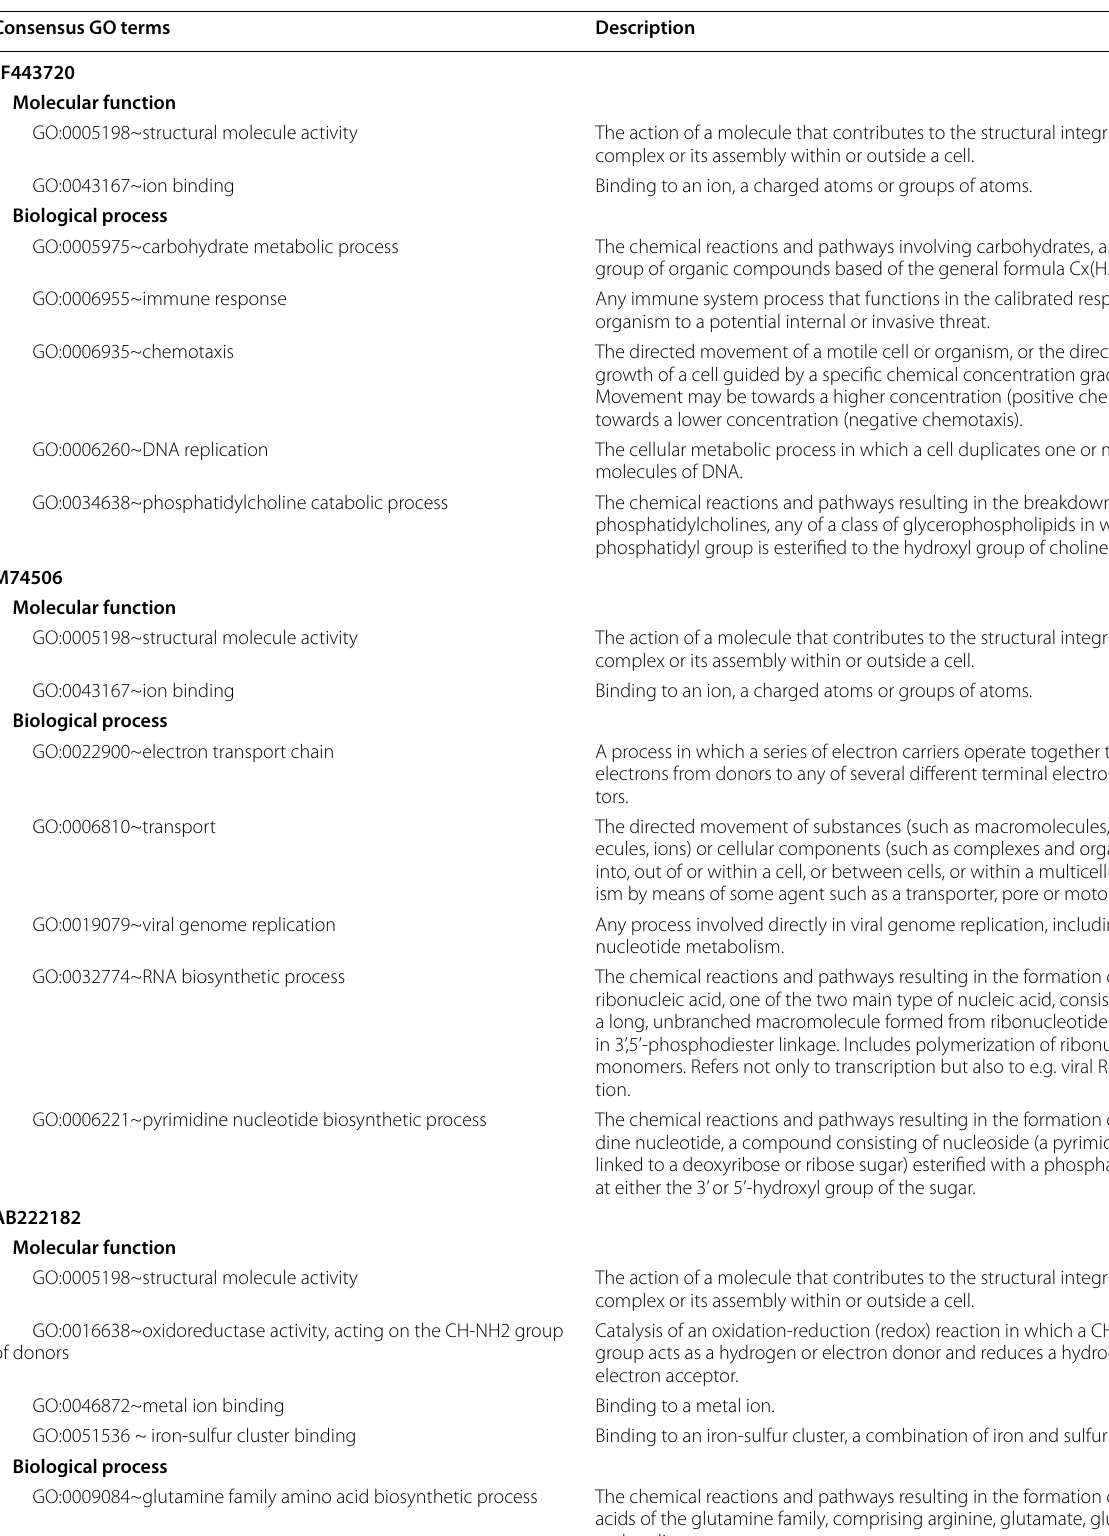
Table 6 Predicted consensus GO terms for homology modeled ORF2